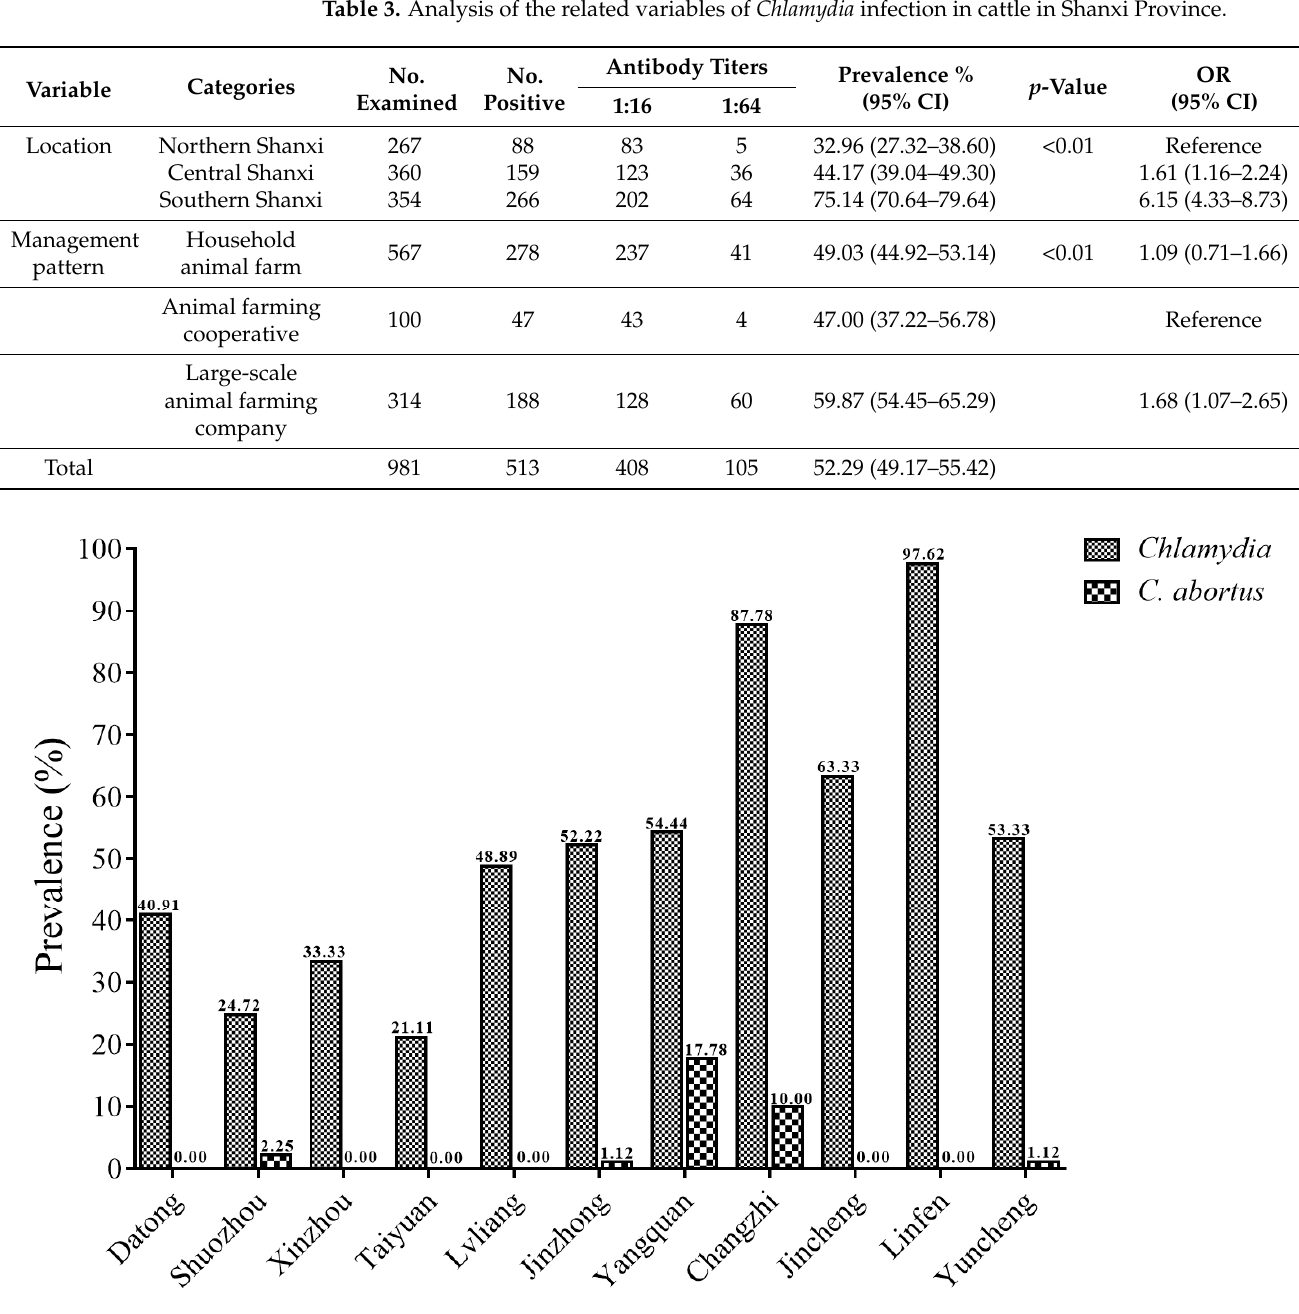
Figure 2. The seroprevalence of Chlamydia and C. abortus infection in cattle in 11 administrative cities in Shanxi Province, north China.